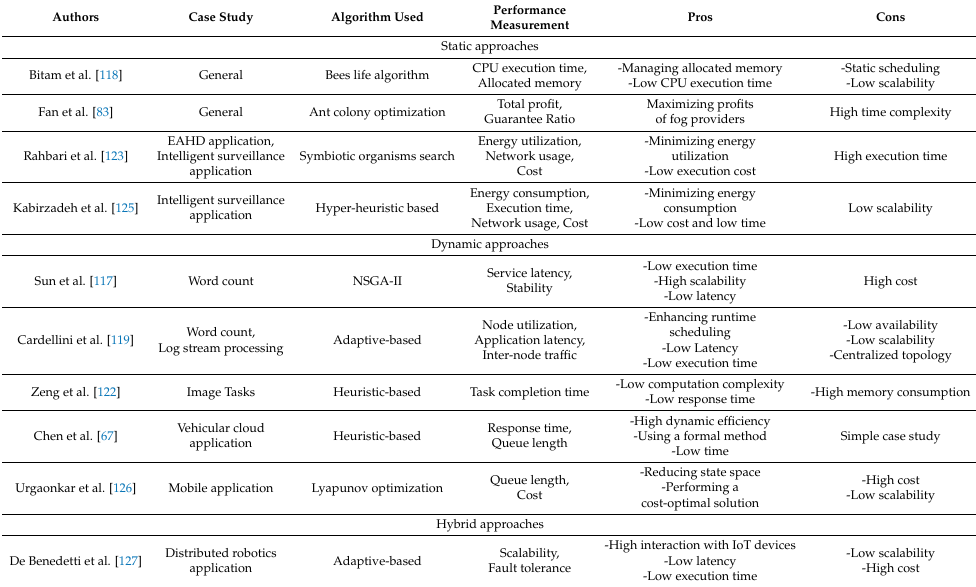
Table 5. Comparison of resource-scheduling